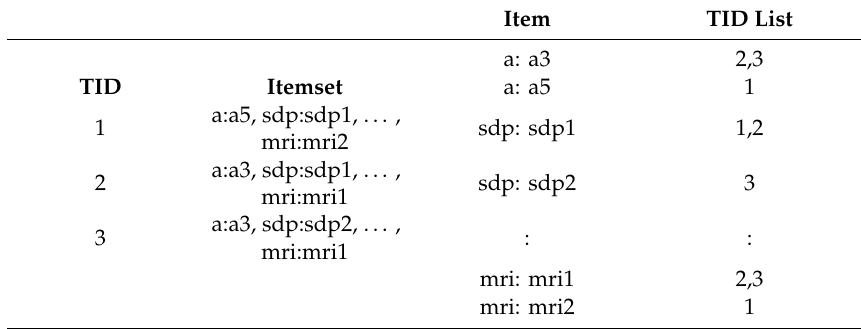
Table 3. An example of transformation of the cerebrovascular examination dataset format.